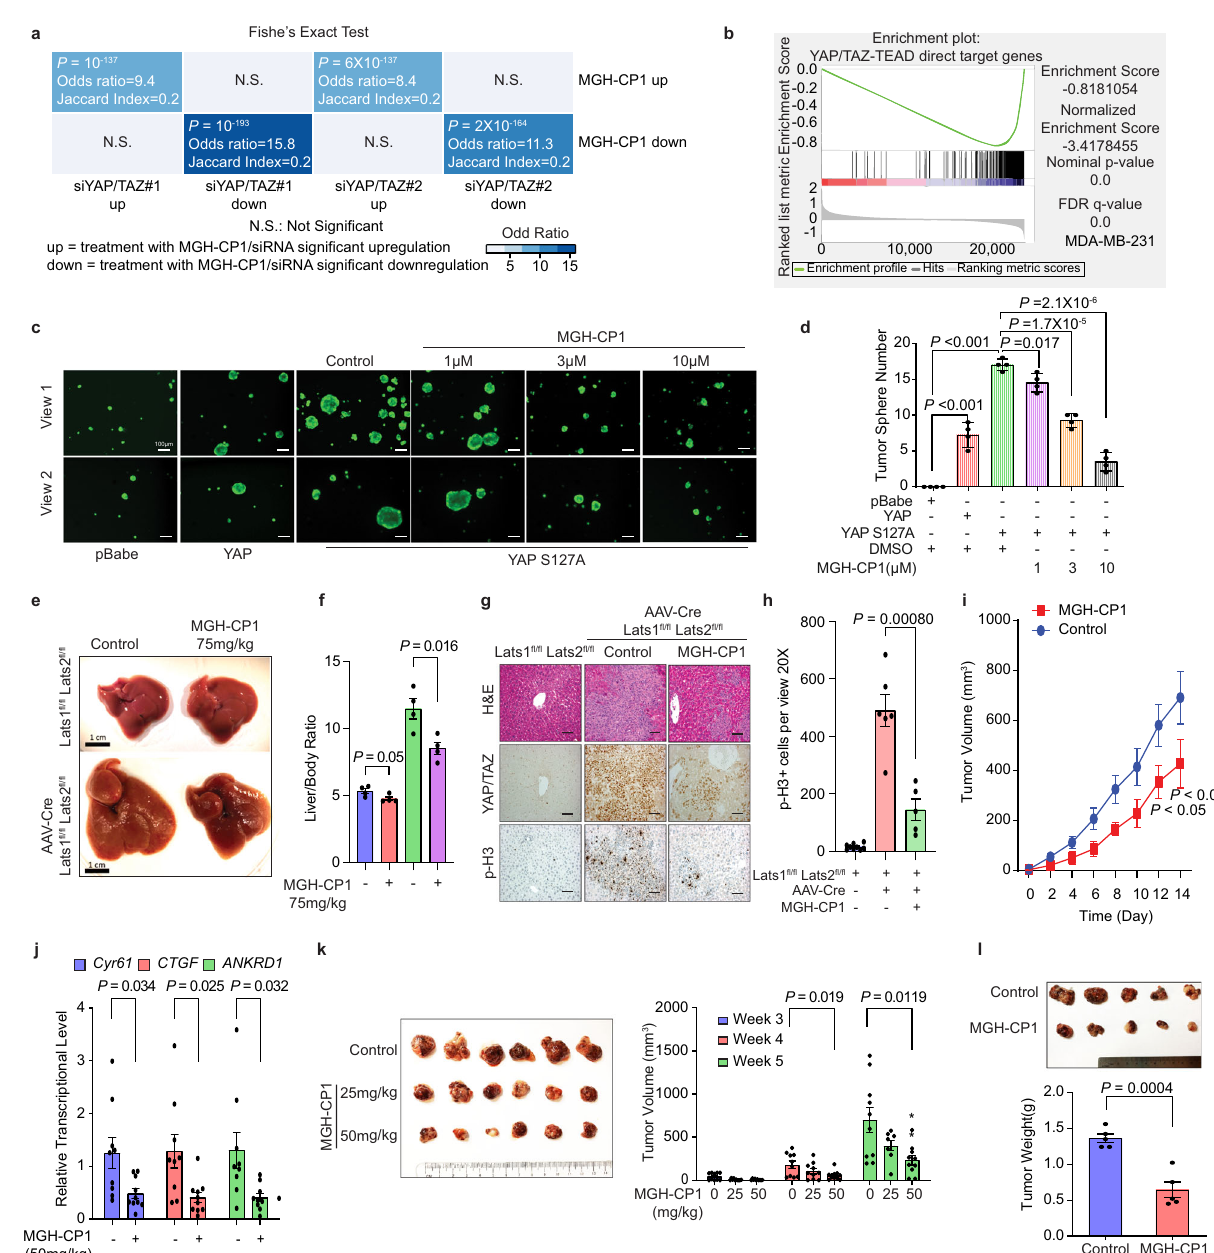
Fig. 2 | MGH-CP1 treatment overlaps with YAP/TAZ suppression in transcrip- tional output and inhibits YAP-dependent transformation, organ enlarge- ment,andtumorinitiation. a Fisher ’ sExactTestusing RNA-seq datasetsof MGH- CP1 (GSE177052) versus YAP/TAZ knockdown (GSE102407) in MDA-MB-231 cells. Two tailed P values are shown. b Gene set enrichment analysis of YAP/TAZ-TEAD targetgenesignatureuponMGH-CP1treatment. c Tumorsphereformationassayof MCF10AcellstransducedwithYAPWTorS127Amutation.IndicateddosesofMGH- CP1 were applied. Tumor sphere numbers were counted in d ( n =4 biological repeats). Scale bar, 100 µ m. e MGH-CP1 inhibits liver enlargement induced by liver speci fi c Lats1/Lats2 deletioninvivo.Scalebar,1cm. f Quanti fi cationofrelativeliver weight of control or MGH-CP1-treated Lats1 fl / fl ;Last2 fl / fl mice with control or Lentiviral-Credelivery( n =4mice). g RepresentativeimagesofhistologyandIHCof YAP/TAZ and phospho-histone H3 (p-H3) in the liver. Scale bar, 50 µ m. (Images were chosen from n =9, 6, 5 histology fi elds for Control, Lats1/Lats2 double knockout and Lats1/Lats2 double knockout with MGH-CP1, respectively)